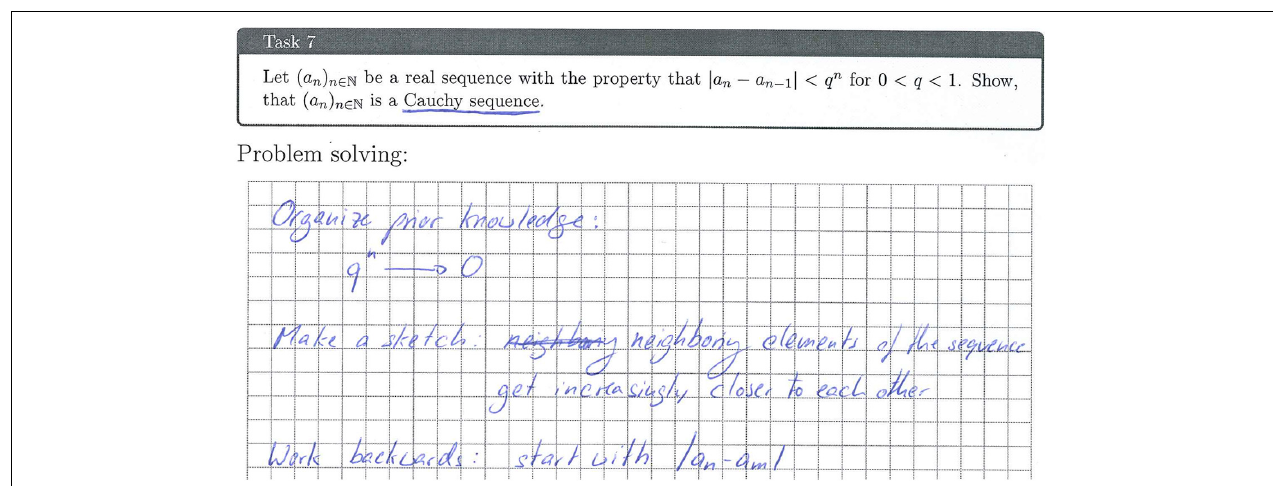
FIGURE 6 | Task description and Leia’s notes regarding problem solving